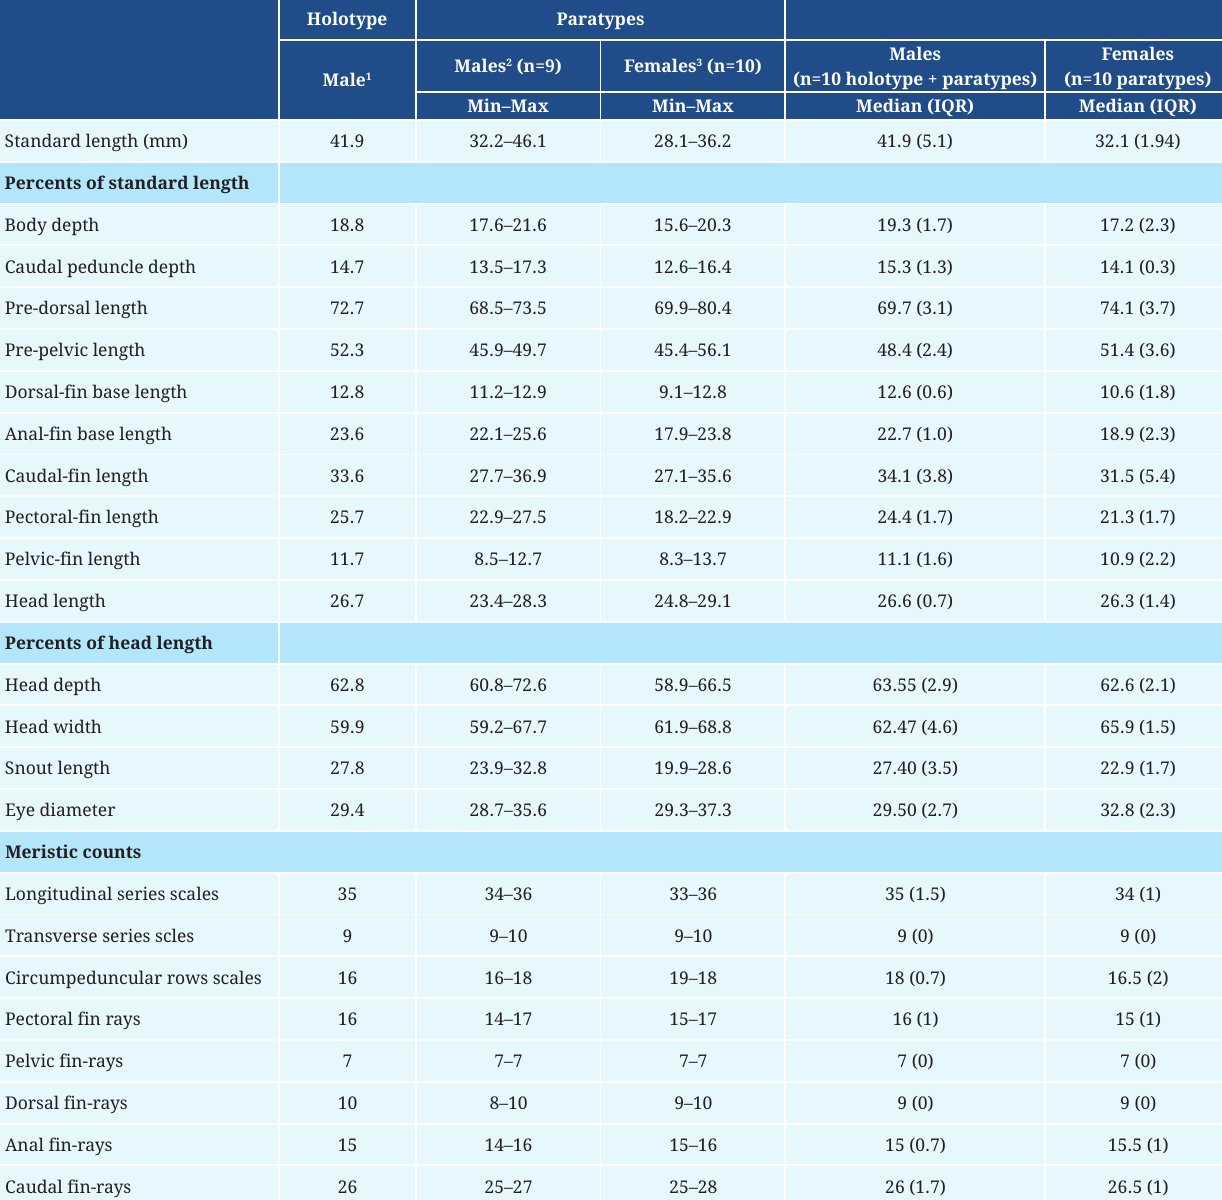
TABLE 1 | Morphometric and meristic data of holotype and paratypes of Moema juanderibaensis . 1: MNKP 16539; 2: MNKP 16540, MNKP 16541, MNKP 16545; 3: MNKP 16543, MNKP